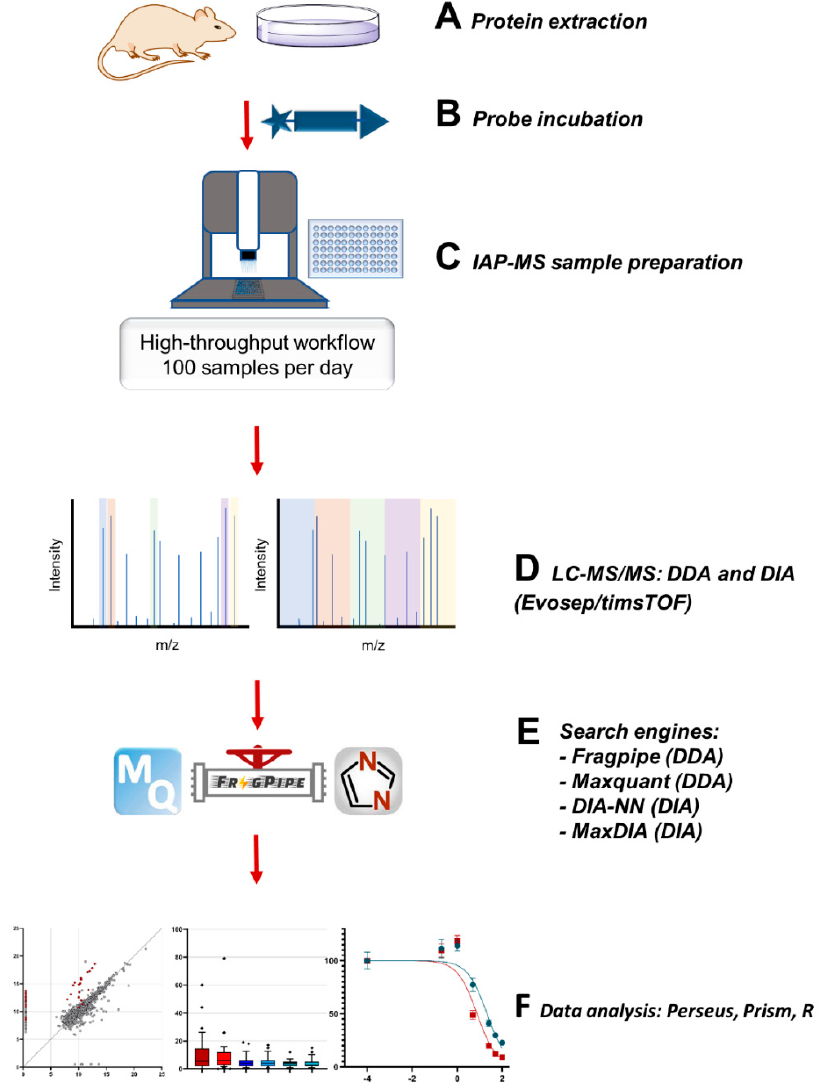
Scheme 1. Data collection (data-independent acquisition (DIA) vs. data-dependent acquisition (DDA)) and analysis comparisons for the development of the ABPP-HT* (enhanced high-through- put-compatible activity-based protein profiling) approach to improve the DUBome depth while